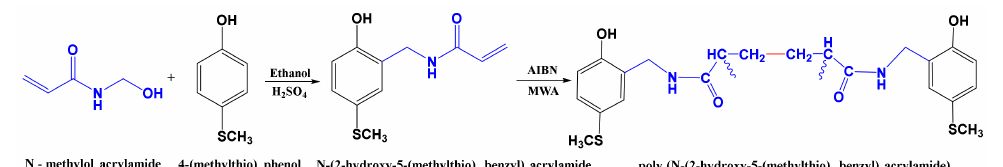
Figure 1. The synthesis route of self-polymer